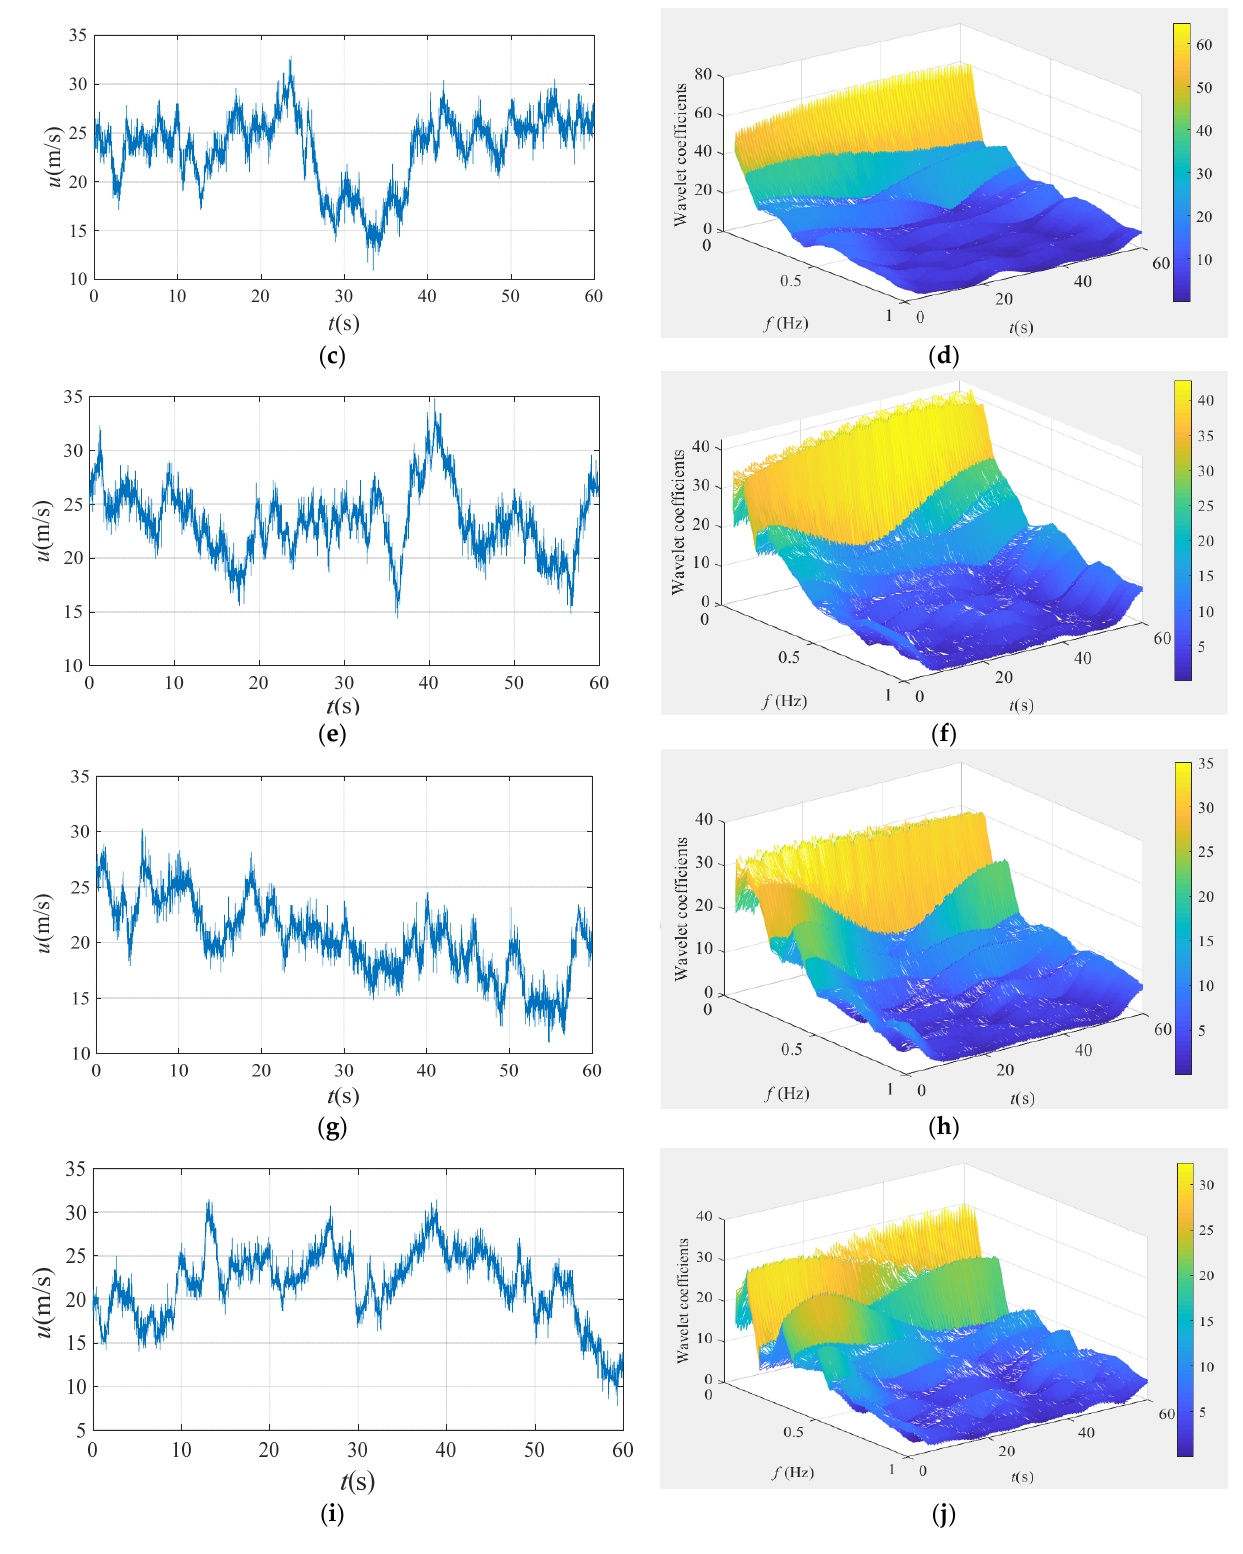
Figure 13. Wavelet time-frequency diagram of five 1-min subsamples. ( a ) Wind speed sample of No. 1; ( b ) Wavelet time-frequency diagram of No. 1; ( c ) Wind speed sample of No. 2; ( d ) Wavelet time-frequency diagram of No. 2; ( e ) Wind speed sample of No. 3; ( f ) Wavelet time-frequency diagram of No. 3; ( g ) Wind speed sample of No. 4; ( h ) Wavelet time-frequency diagram of No. 4; ( i ) Wind speed sample of No. 5; ( j ) Wavelet time-frequency diagram of No. 5.